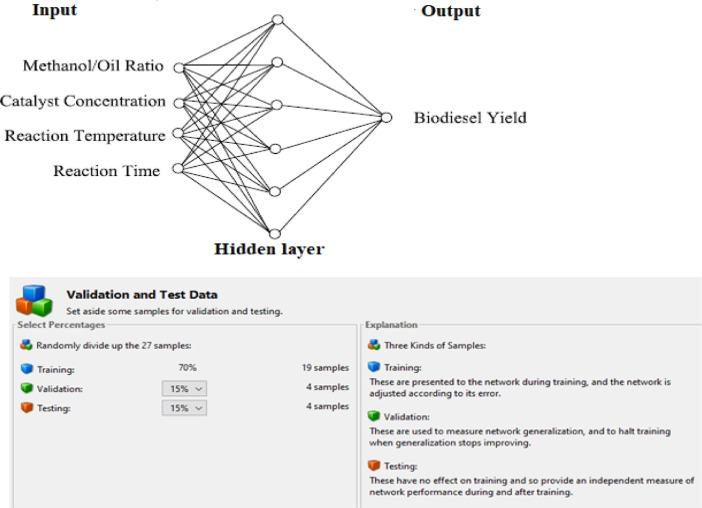
ANN Architecture